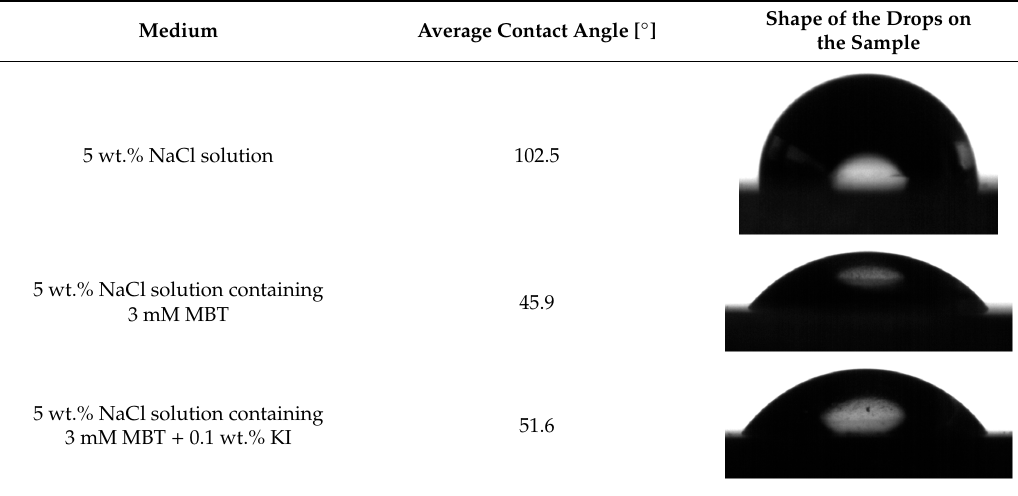
Table 3. Average contact angle values (out of three replicate measurements) and the shape of the respective drop (one example) for the ground AA6082 aluminium alloy samples immersed for 1 h in 5 wt.% NaCl solution containing 0.3 mM MBT or a combination of 0.3 mM MBT and the addition of 0.1 wt.% KI at 25 ◦ C.